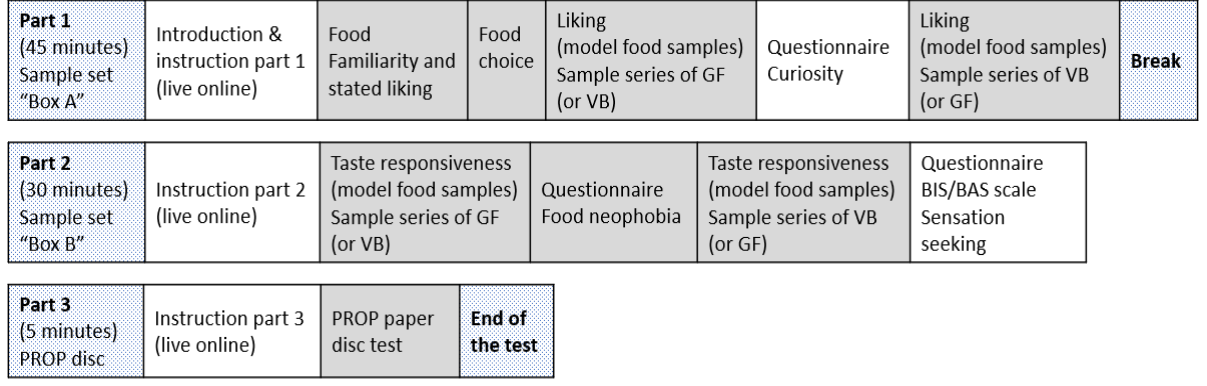
Figure 1. The study scheme (variables in grey show areas of interest reported in this paper). All the tests were conducted at schools with one class taking the test at a time (15–22 participating children per class, 9 classes in total). Children were seated at in- dividual tables, distanced from one another. The instructions were provided to the children at the beginning of each part (i.e., what the children should do, what samples they should taste, the explanation of the scales, etc.) with the support of a PowerPoint presentation (Microsoft Corporation, Redmond, Washington, United States). All instructions were provided via video conference call (Microsoft Teams, Microsoft Corporation, Redmond, Washington, United States) as there were restrictions in visiting the schools physically due to the Covid-19 pandemic. The video call was projected onto a large screen or smartboard in front of the class allowing the children to see and hear the instructions clearly. A video camera was turned on in the classroom during the entire evaluation, thus enabling the experimenters to monitor the test remotely. The children and teachers were able to ask questions directly to the instructor during the test and it took around two hours to finish the entire testing session (including a break). There was at least one teacher physically present in the room for the entire testing time, who assisted the experimenters with all practicalities in the classroom (i.e., placing the sample boxes on the children’s table, pouring the water for each child, helping with the camera and screen setting in the class, etc.). A separate discussion with the teachers took place before the evaluation day to inform them about the whole testing procedures, timing, and to ensure that good sensory practices would be followed during the